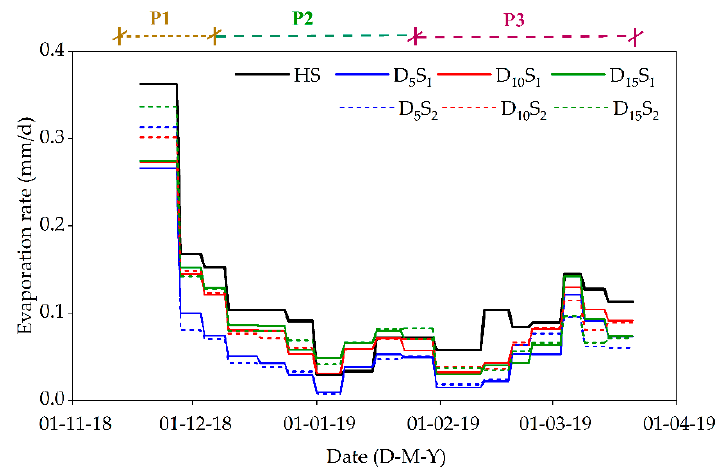
Figure 8. Evaporation rates of homogeneous and sand-layered soil columns during the seasonal freeze–thaw period. freeze–thaw